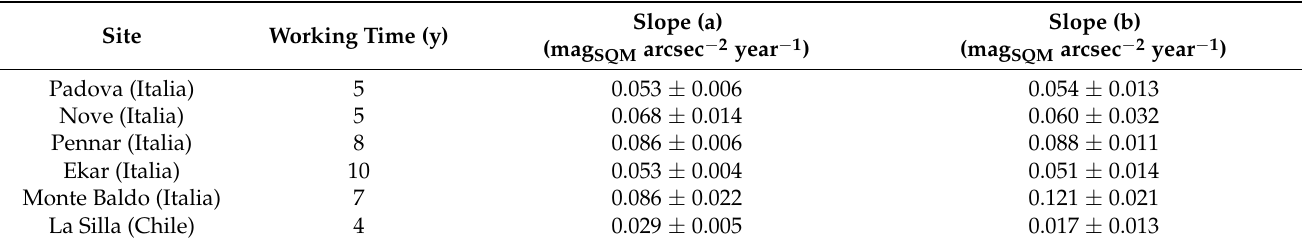
Table 2. Values of the working time and of the slope of the equation of the line interpolating the daily data for each considered site; slope column (a) consider daily data, while column (b) considers yearly average